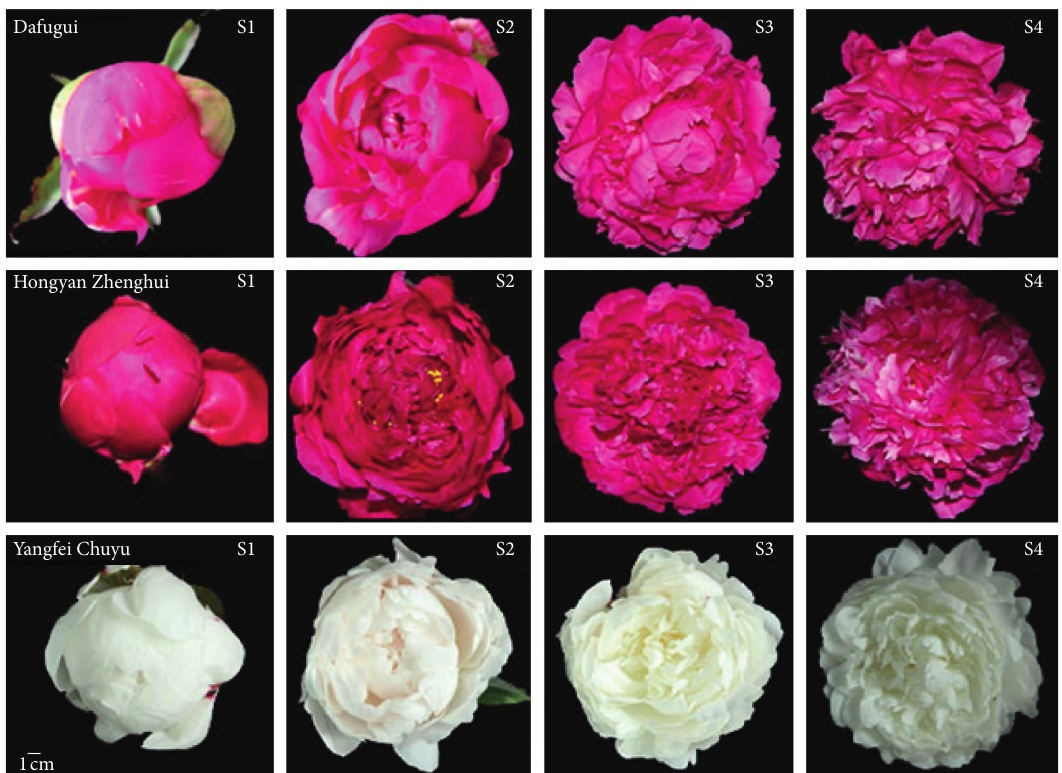
Figure 1: Petals of three P. lactiflora cultivars at different developmental stages.